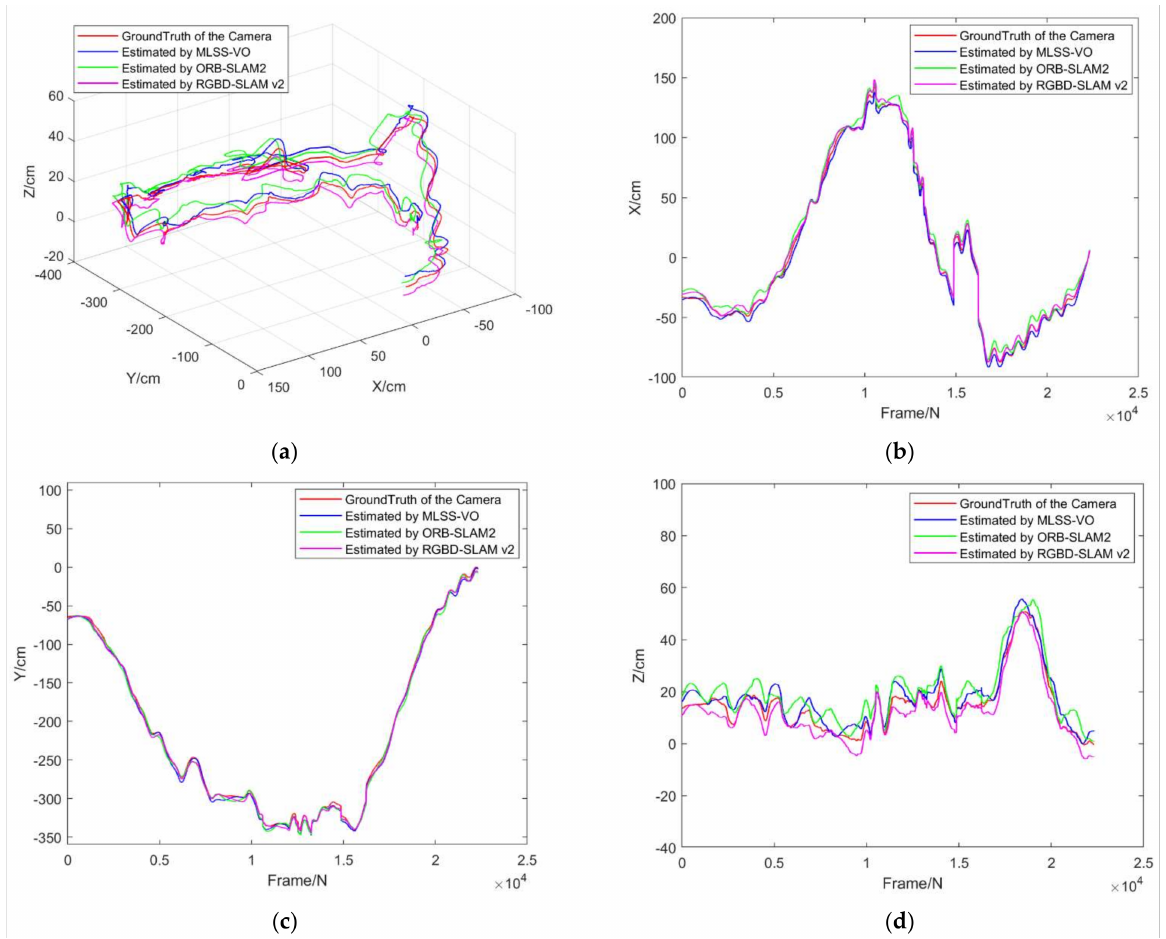
Figure 18. Schematic diagram of the test trajectories of MLSS-VO, oriented fast and rotated brief (ORB)-SLAM2 and RGBD-SLAM v2 in the TUM_desk dataset: ( a ) comparison of three-dimensional trajectories; ( b ) comparison of x -axis; ( c ) comparison of y -axis; ( d ) comparison of z -axis.